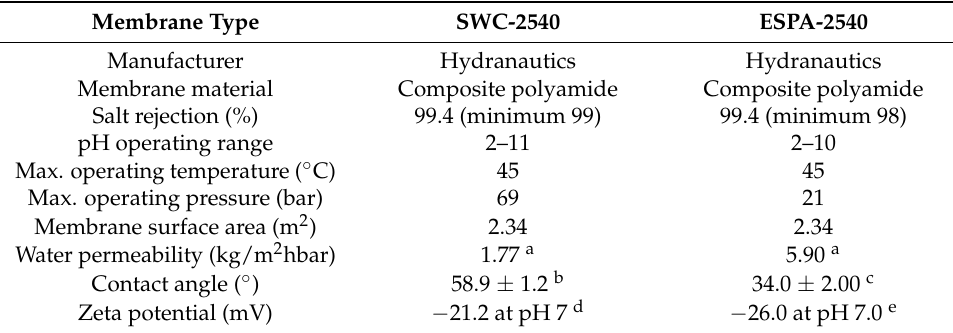
Table 1. Characteristics of spiral-wound membrane